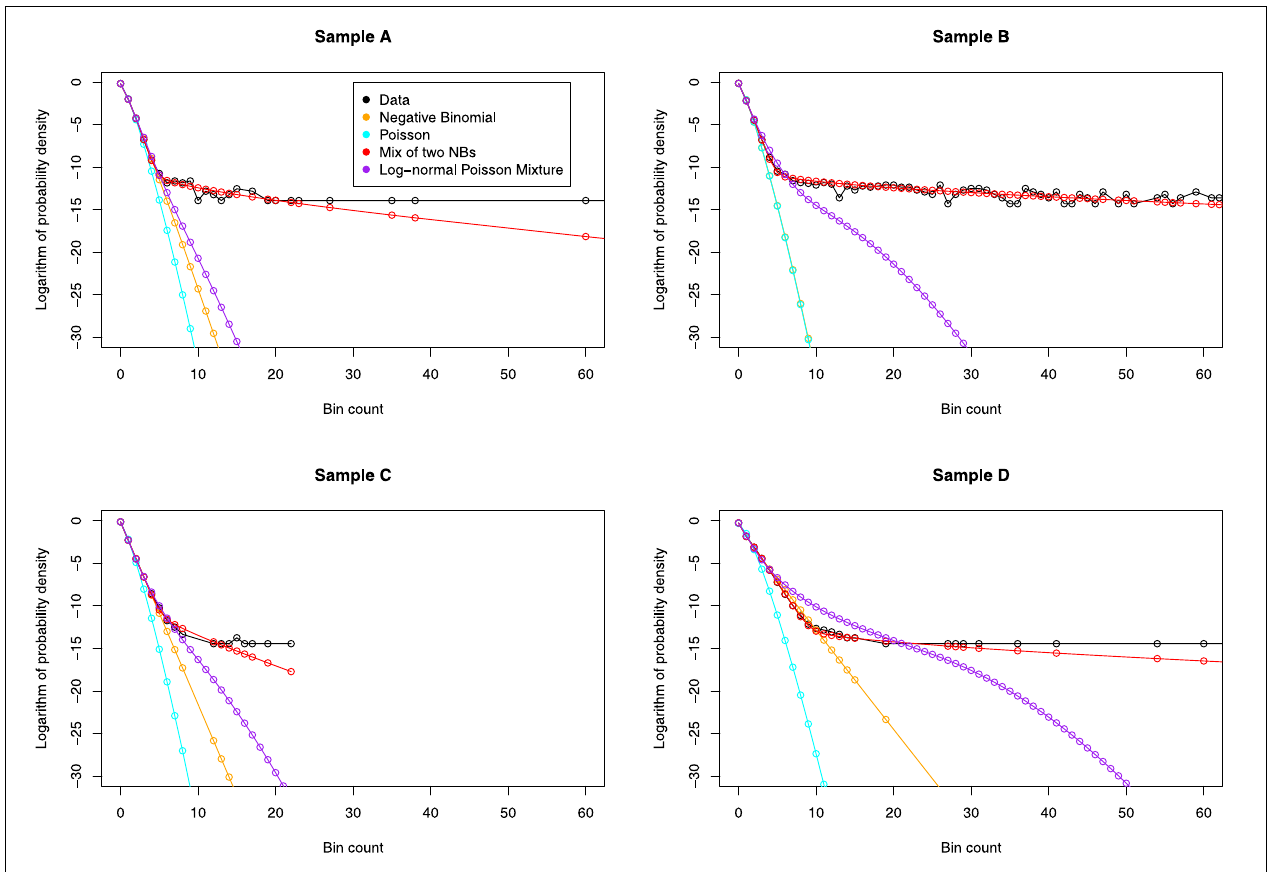
FIGURE 4 | The fit of various distributions to the count data. We again see a striking change of behavior, occurring at around x = 9. The only distribution that can model this change is the NB-NB mixture.